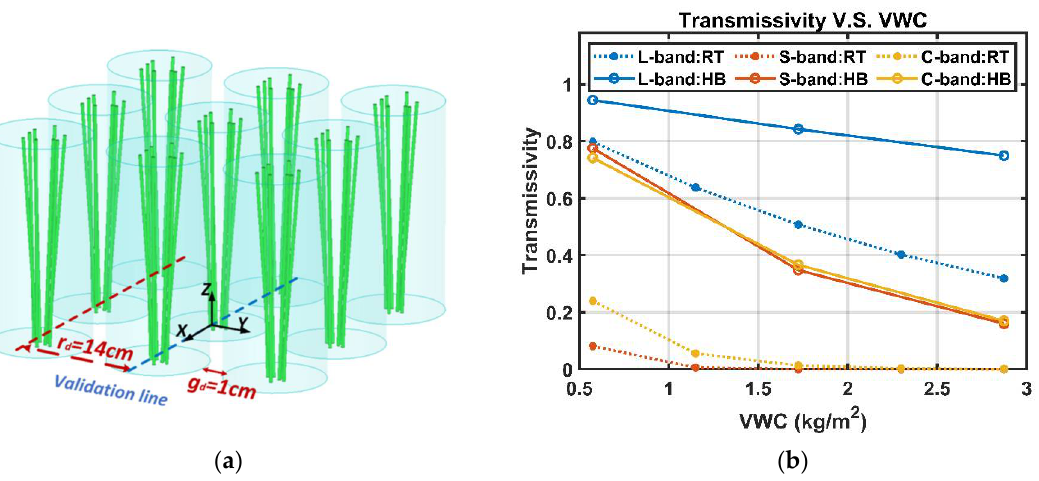
Figure 7. ( a ) Scattering from wheat plants in the radius of the circumscribing cylinder, 6.5 cm; dis-